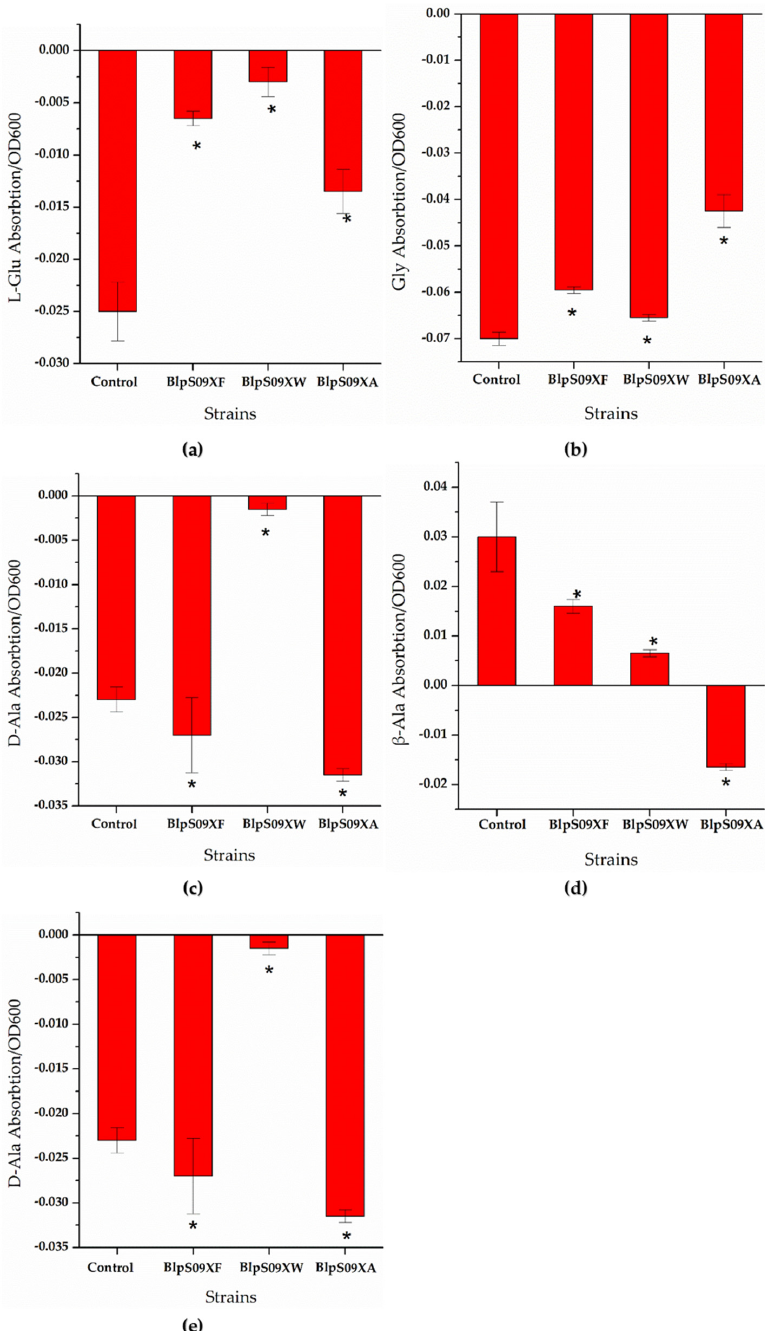
Figure 4. ( a ) The ratio of the extracellular L-Glu concentrations of the strains overexpressing amino acid permease mediated by promoter Pshuttle09 - XBS to the cell concentration; ( b ) the ratio of the extracellular Gly concentrations of the strains overexpressing amino acid permease mediated by promoter Pshuttle09 - XBS to the cell concentration; ( c ) the ratio of the extracellular D-Ala concentrations of the strains overexpressing amino acid permease mediated by promoter Pshuttle09 - XBS to the cell concentration; ( d ) the ratio of the extracellular β -Ala concentrations of the strains overexpressing amino acid permease mediated by promoter Pshuttle09 - XBS to the cell concentration; ( e ) the ratio of the extracellular D-Ser concentrations of the strains overexpressing amino acid permease mediated by promoter Pshuttle09 - XBS to the cell concentration. A wild-type strain with plasmid pHY300-PLK was used as a comparison. Each experiment was repeated at least three times; data are represented as the means of three replicates and bars represent the standard deviations. * p < 0.05 indicates the significance levels between recombinant strains and the control